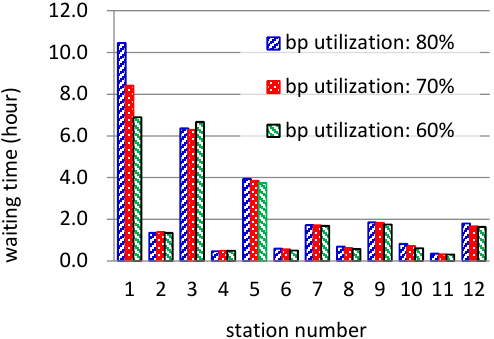
Figure 6. Waiting time at each station with different BP utilization levels.